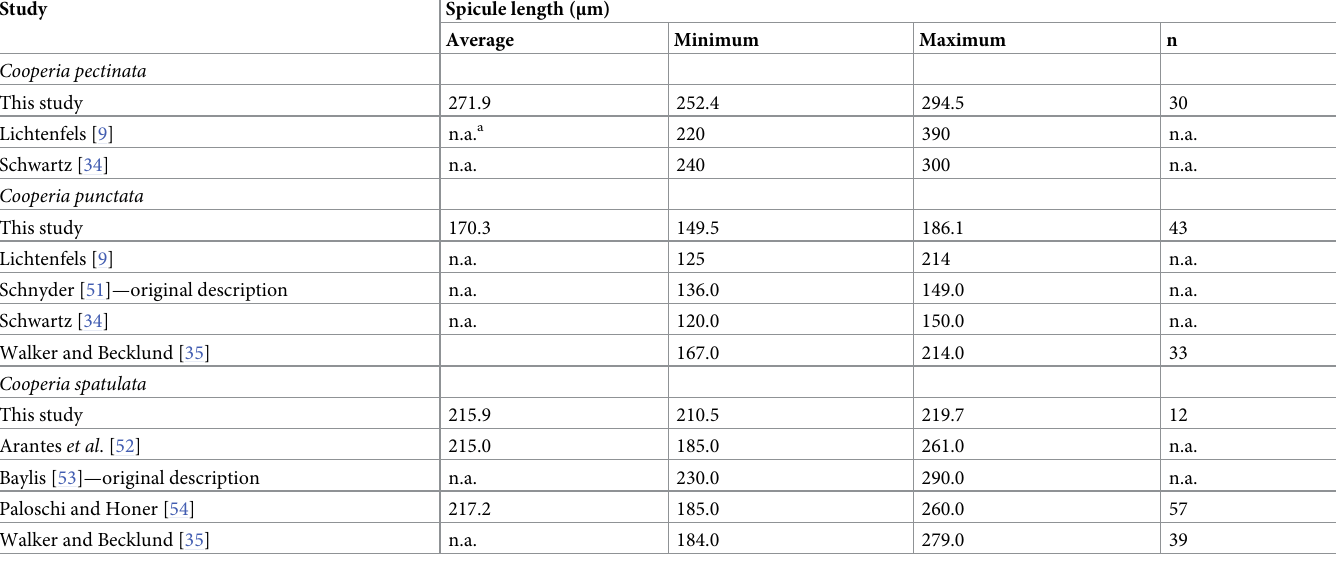
Table 1. Average, minimum and maximum spicule length of Cooperiapectinata , Cooperiapunctata and Cooperiaspatulata reported in different